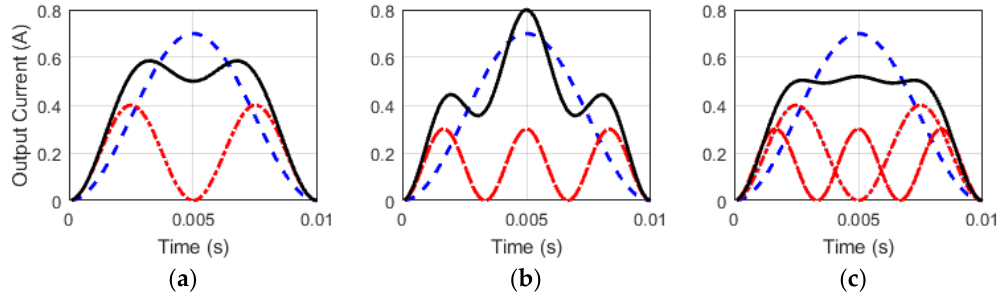
Figure 1. Different cases of the output current waveforms and its circuit diagram under harmonic injection [10,11]. ( a ) Combination of double and third line harmonics orders; ( b ) Combination of double and fifth line harmonics orders; ( c ) Combination of double, third and fifth line harmonics orders.